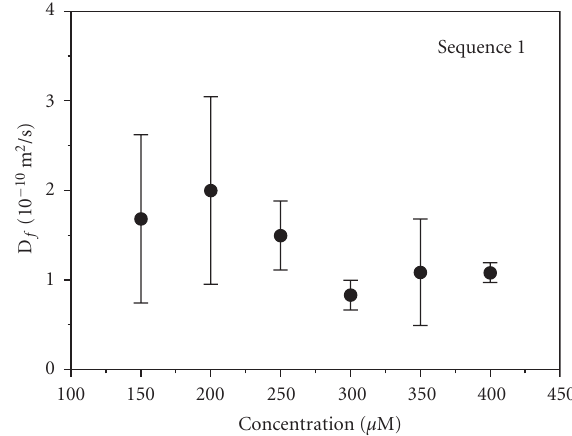
Figure 6: Di ff usion coe ffi cient of the fast di ff usive mode as a function of oligonucleotide concentration. Measurements for dialysed sequence